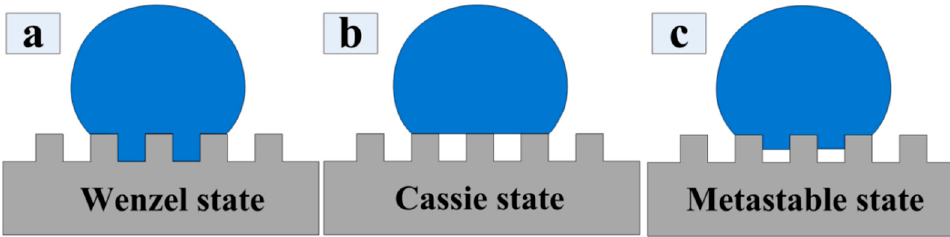
Figure 1. Schematic diagrams of the Wenzel state, Cassie state, and metastable wetting state.